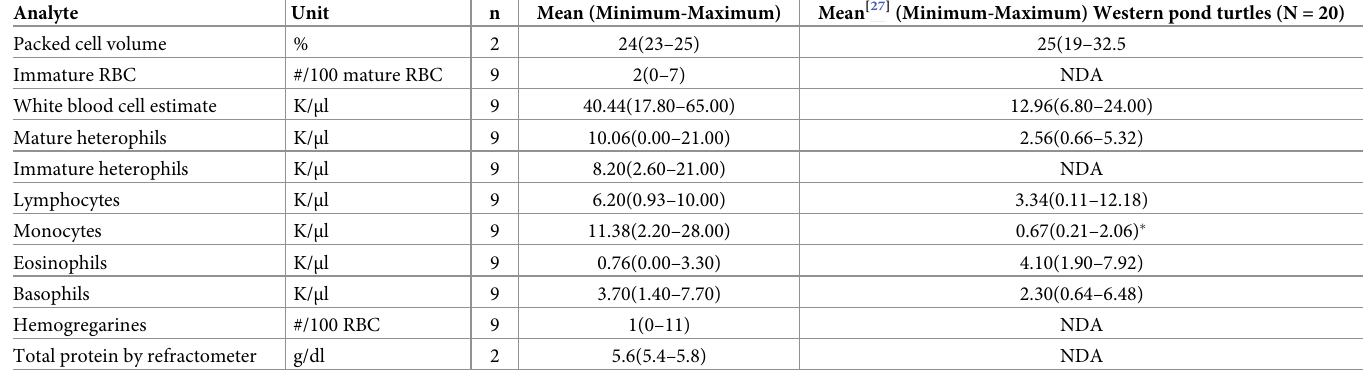
Table 3. Hematological data of freshwater turtles (N = 5 Apalone ferox ; N = 4 Pseudemys spp.) infected with Turtle fraservirus 1. RBC = red blood cells. NDA = no data